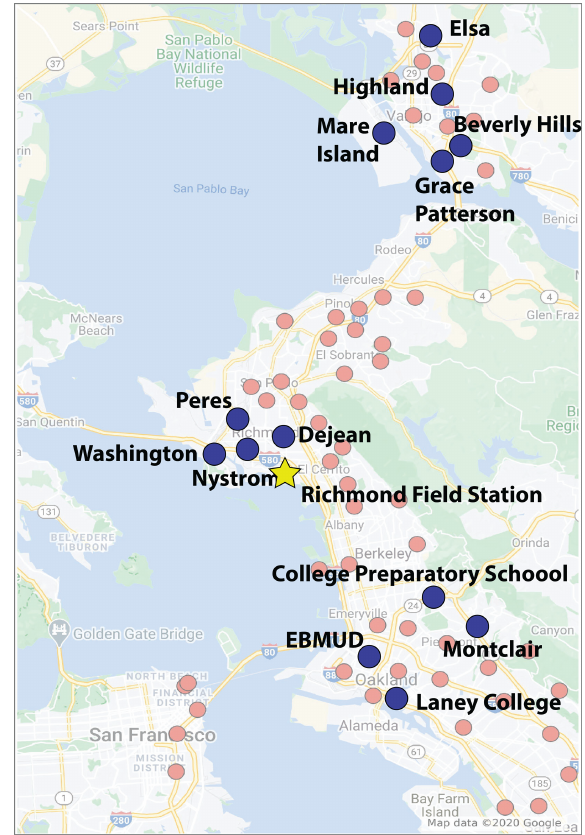
Figure 1. Map of all Bay Area BEACO 2 N sites (small red dots), BEACO 2 N sites discussed in this work (large blue dots), and the Richmond Field Station